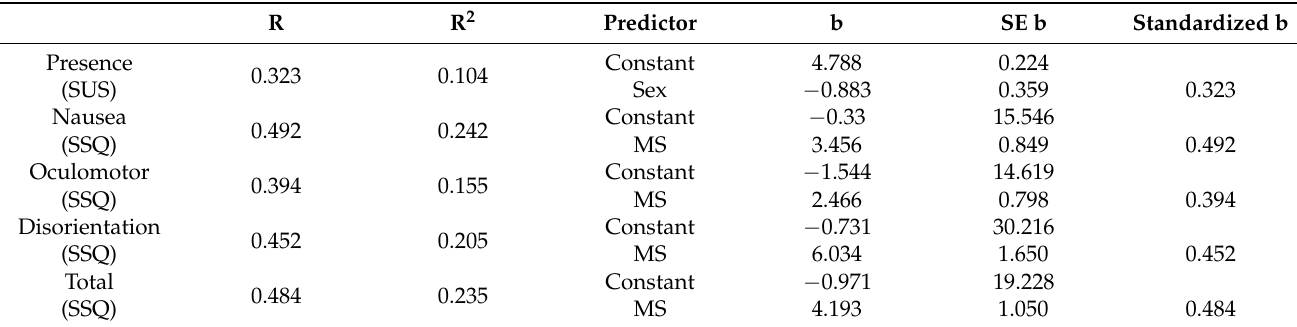
Table 4. Results of the regression analyses for the dependent variables: Presence and simulator sickness subscale (Nausea, Oculomotor, and Disorientation sub-scores) and total